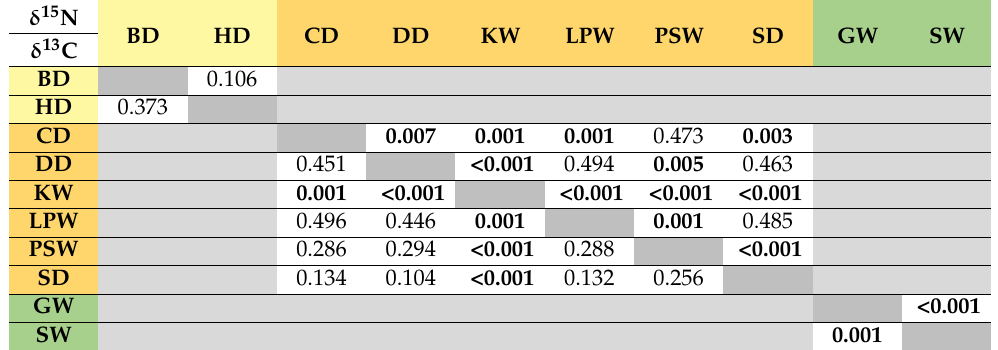
Table A1. Results of pairwise comparisons (randomisation test) of δ 15 N and δ 13 C isotopic values between odontocete species with n ≥ 7. Significant values (at 0.05 level) denoted in bold. Neritic group (yellow): BD = bottlenose dolphin, HD = Hector’s dolphin, mesopelagic group (orange): CD = common dolphin, DD = dusky dolphin, KW = killer whale, LPW = long-finned pilot whale, PSW = pygmy sperm whale, SD = striped dolphin, bathypelagic group (green): GW = Gray’s beaked whale, SW = sperm whale. Dark grey indicates matrix diagonal, light grey fields refer to species not in the same